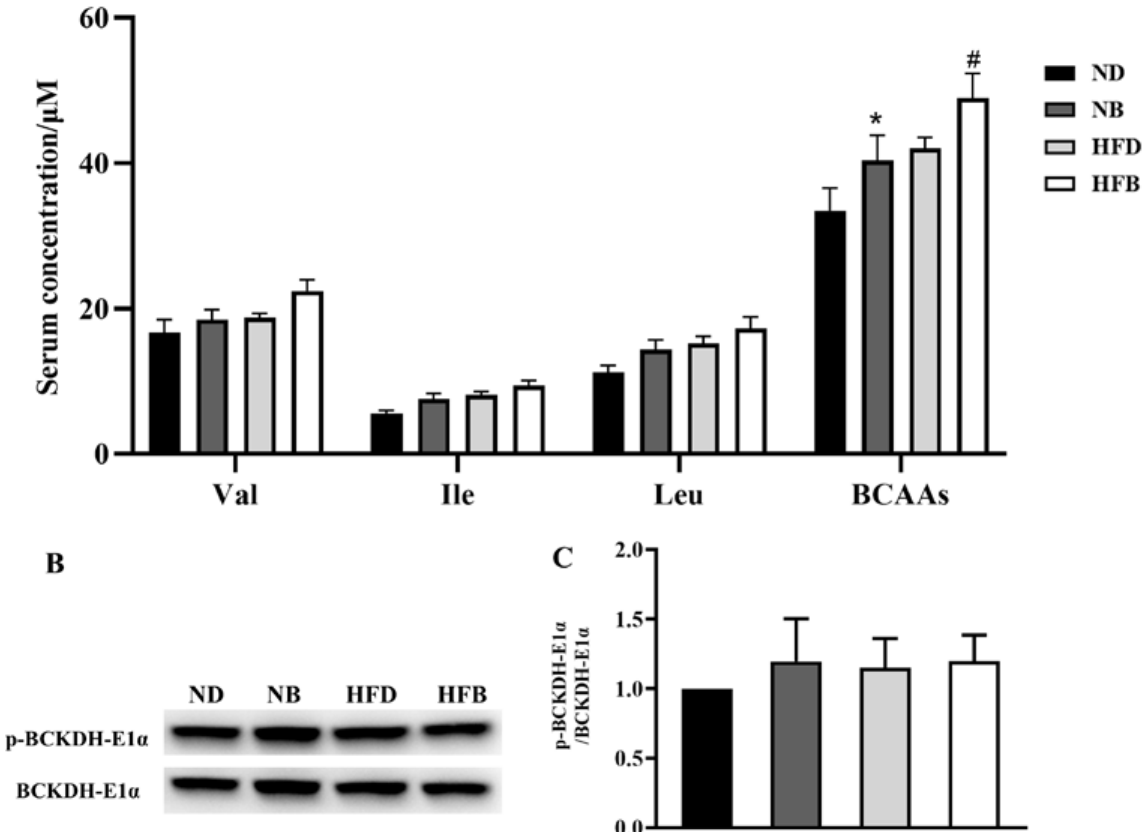
Figure 3. Effects of BCAA supplementation on serum levels of BCAAs and BCAA metabolic enzymes in ApoE − / − mice. ( A ) Serum Val, Ile, Leu and total BCAA concentrations were determined by an LC − MS/MS method. ( B ) Western blotting was used to assess p -BCKDH-E1 α and BCKDH-E1 α protein expression in the liver. ( C ) The relative quantitative values for p -BCKDH-E1 α /BCKDH-E1 α are indicated. Densitometry values were normalized to β -actin. The data are expressed as the mean ± SEM ( n = 8 for each group). * p < 0.05 vs. ND group; # p < 0.05 vs. HFD group.